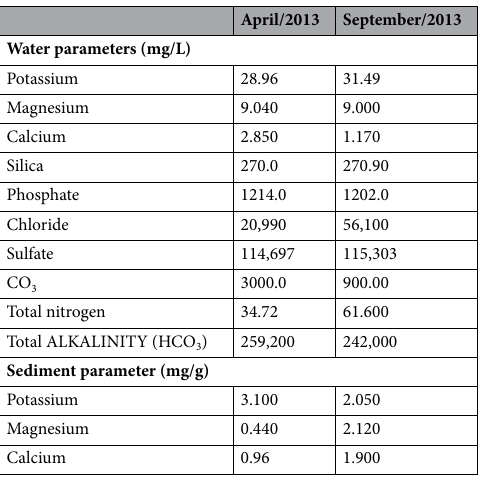
Table 1. Water and sediment samples analysis. Triplet tests were performed and the average of three readings was considered as the final.